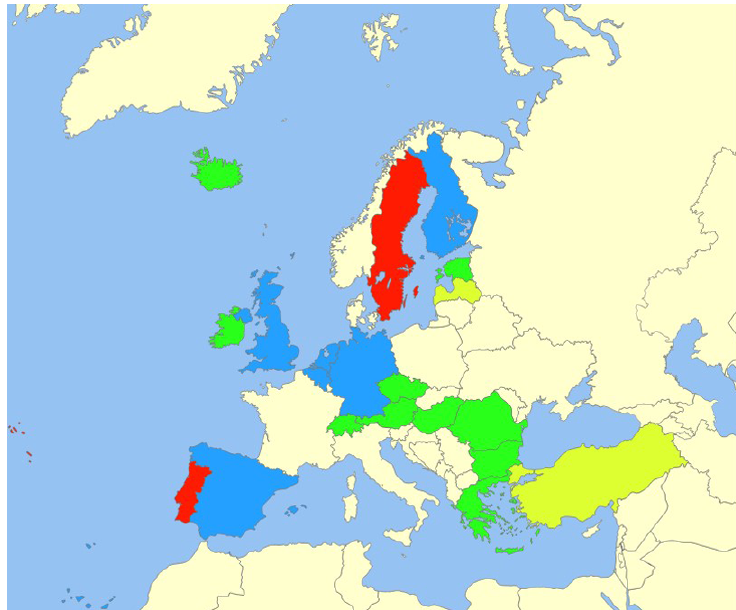
Figure 1. Four clusters of the press based on MIPEX and journalists’ perception of their role as promoting tolerance and cultural diversity.